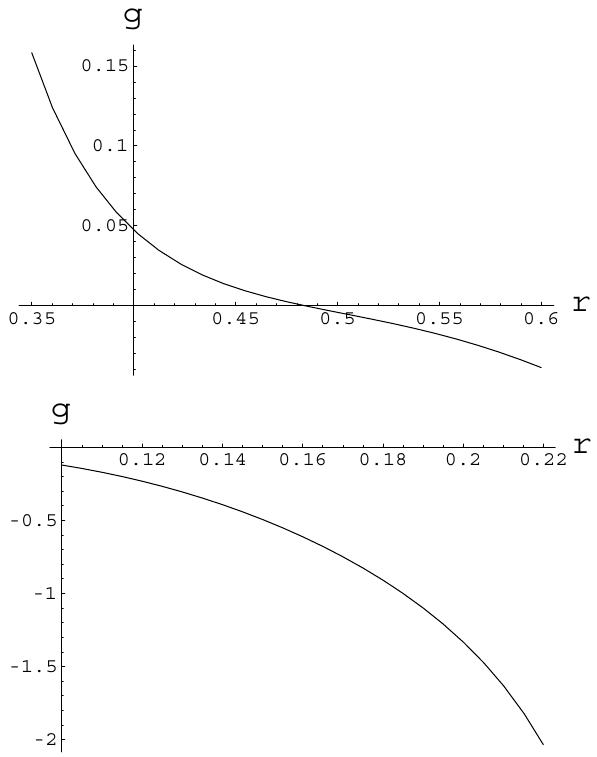
Fig. 4. ( a ) The imaginary part (g) of the dispersion relation of ther- mal electron on closed magnetic field lines (Eq. (29)) of Mars shown versus frequency. Both the frequency and imaginary part (or growth rate) are normalized to the electron gyrofrequency, r = ω/ω He . Only frequencies less than the gyrofrequency are considered. This curve is for a ratio of 0.25 between the concentration of the tran- sient distribution and of the loss-cone distribution. For r< 0 . 47 the growth rate is positive, indicting wave growth. ( b ) Same as Fig- ure 4a, but more for a ratio of 0.4 between the concentrations of the transient component and the trapped component. For this case the trapped component is reduced compared to the case shown in Fig. 4a. There is no growth of waves in the range 0 . 1 <r< 0 . 22. Cal- culation also shows that for r> 0 . 56 there is negative growth. For a ratio of 0.4 there are no unstable waves. Only for fairly large trapped thermal electron population (ratio ∼ 0.25) are waves